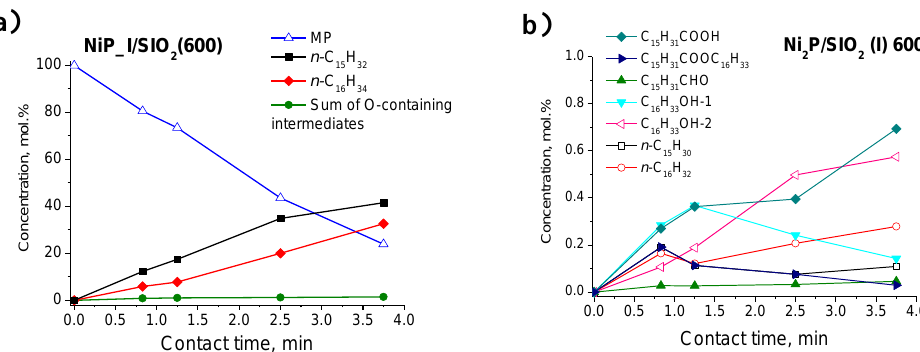
Figure 11. Temperature effect on the conversion of methyl palmitate (solid symbols, solid lines) and oxygen-containing compounds (empty symbol, dash lines) over NiP_I/Al 2 O 3 and NiP_I/SiO 2